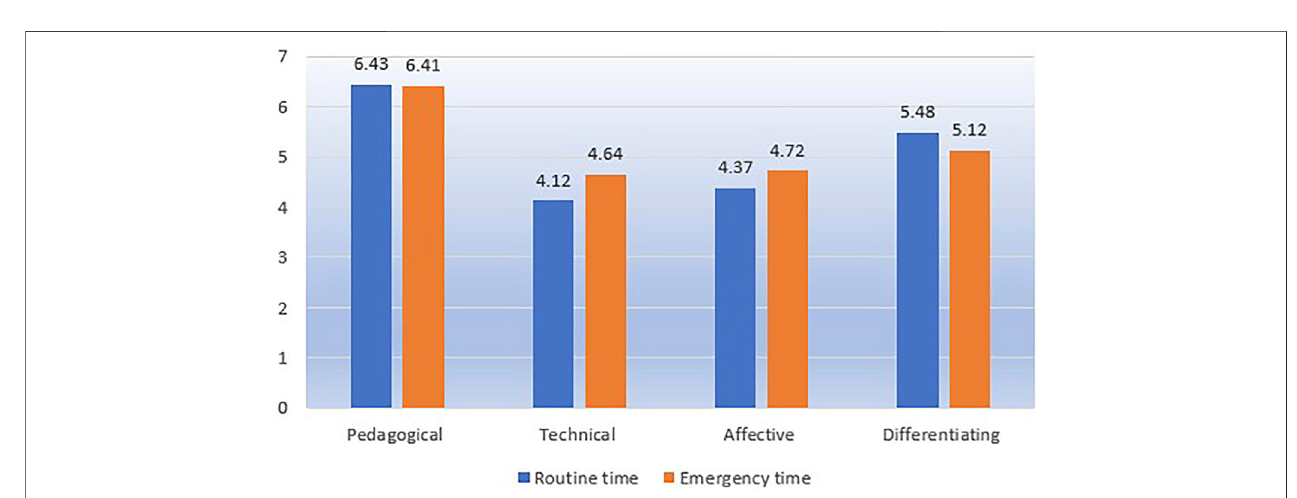
FIGURE 1 | Mean score for each factor of perceptions of teachers ’ roles in online courses during routine and emergency periods.